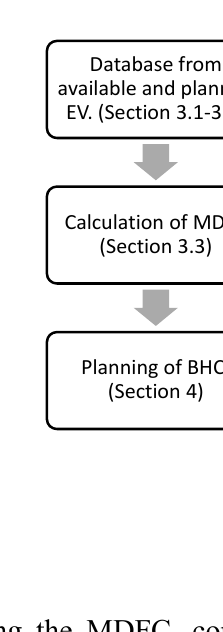
Figure 1. Process for highway fast charging infrastructure planning. EV: electric vehicle; MDFC: Maximum Distance between Fast Charge; and BHCI: Basic Highway Charging Infrastructure.